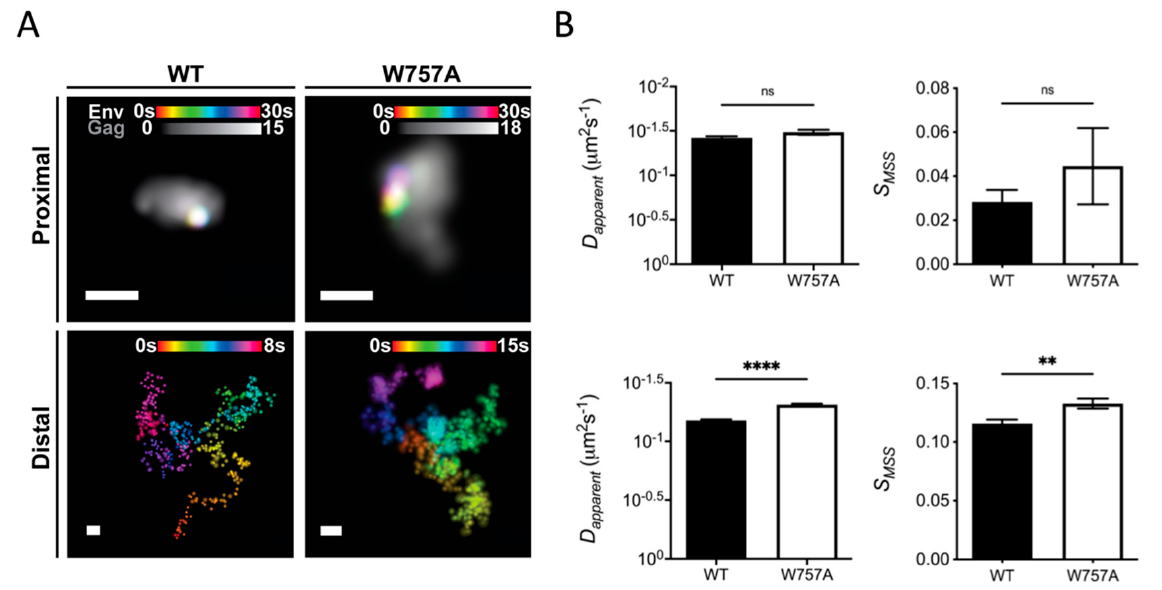
Figure 3. W757A EnvCT does not display a Gag lattice trapping defect at virus assembly sites. CEM-A adherent T cells were transduced with WT and W757A mutant envelope virus and imaged after 48 h. ( A ) Super-resolution reconstructions of Gag and lattice-proximal/-distal single-molecule localisations of Env are demonstrated (Scale bars = 200 nm). Arrows highlight highly confined single- molecule localisations of Env. Proximal and distal single-molecule localisations show the confined and freely diffusing nature of single Env trimers, respectively. ( B ) Wild-type and mutant Env trimers do not differ in mobility when lattice-proximal (top panels) (WT: D apparent = 0.038 µ m 2 s − 1 , S MSS = 0.01; W757A: D apparent = 0.033 µ 2 s − 1 , S MSS = 0.045), whereas lattice-distal diffusion differs significantly between viruses (bottom panels) (WT: D apparent = 0.066 µ 2 s − 1 , S MSS = 0.116; W757A: D apparent = 0.049 µ 2 s − 1 , S MSS = 0.133). Statistical significance was determined by unpaired two- = 0.29; distal: P = 0.19, sample t -test ** p < 0.01, **** p < 0.0001 (proximal: P D = 9.22 × 10 − 24 , P S D MSS = 0.0016) N = distal: N P S WT = 3652, N W757A = MSS